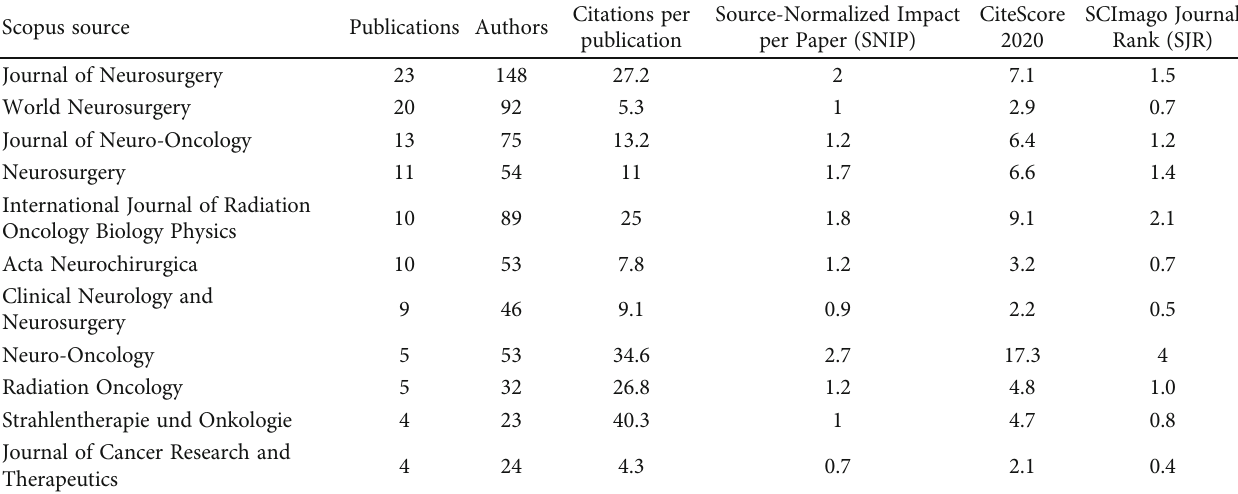
Table 4: Top 10 of all publication types of knife surgery by Scopus